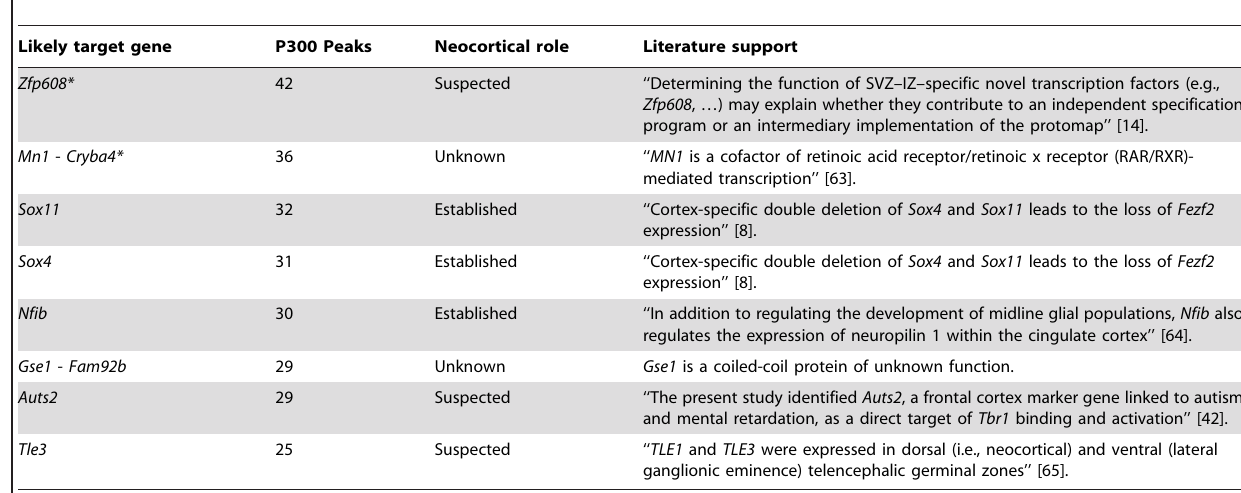
Table 2. The ten genes most enriched for the abundance of p300 peaks in their GREAT gene regulatory domains.